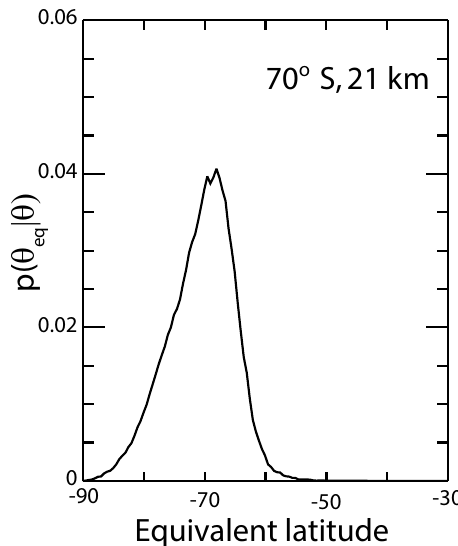
Figure 12. Distribution of equivalent latitude (per degree) for Au- gust at 70 ◦ S and 21km based on a 10-year average of MERRA observations for 2001 to